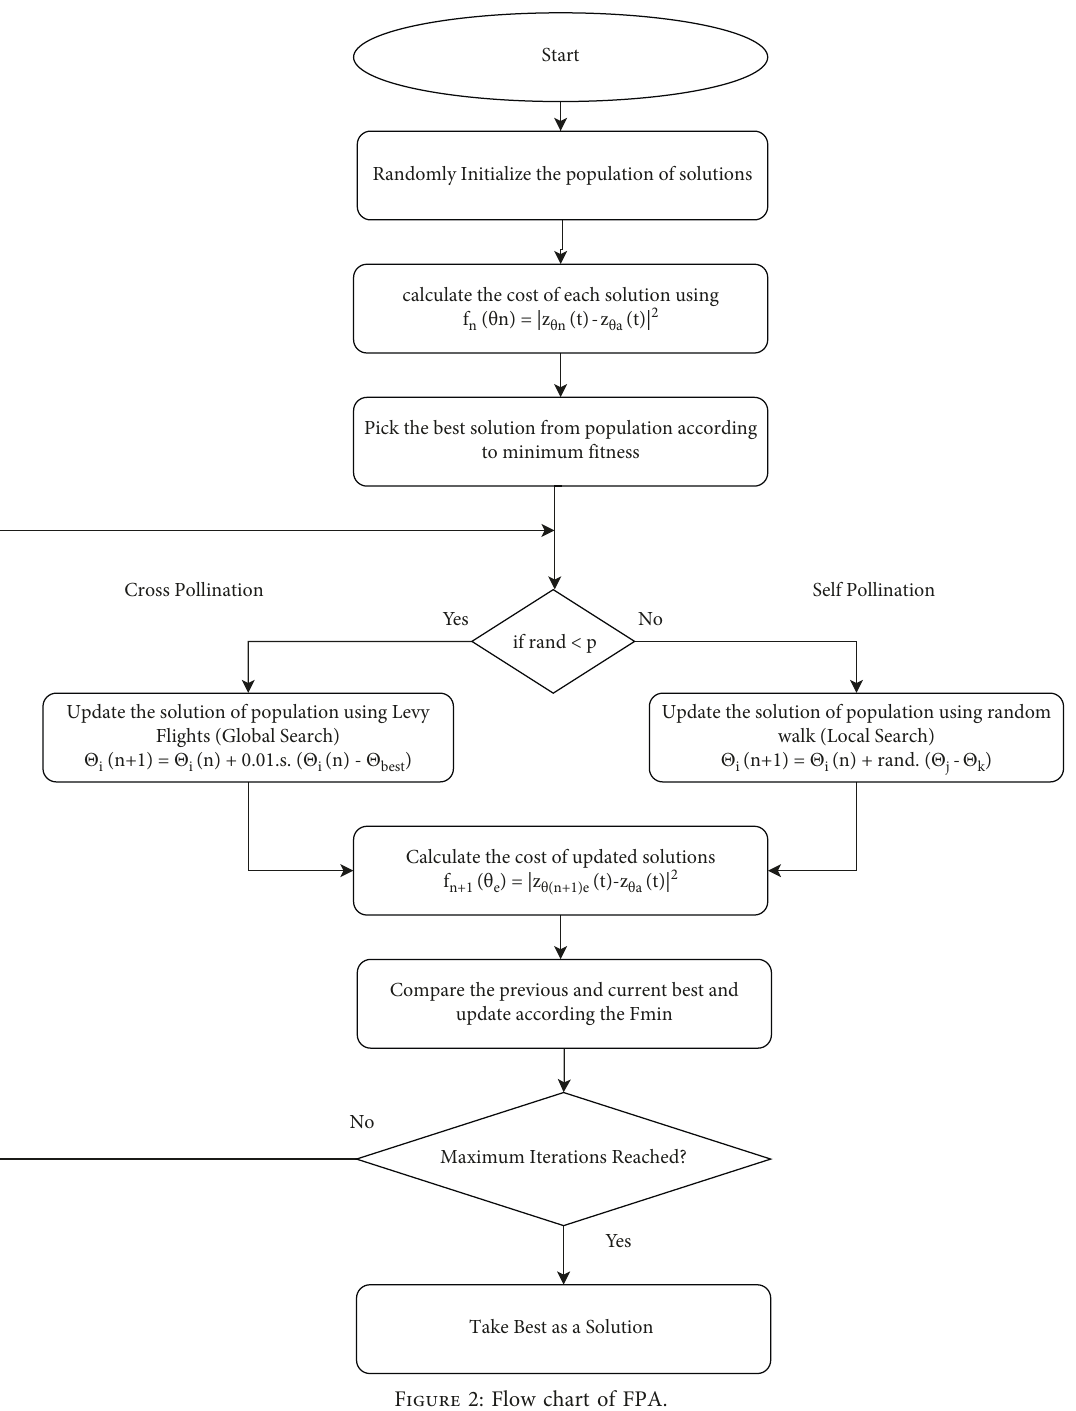
Figure 2: Flow chart of